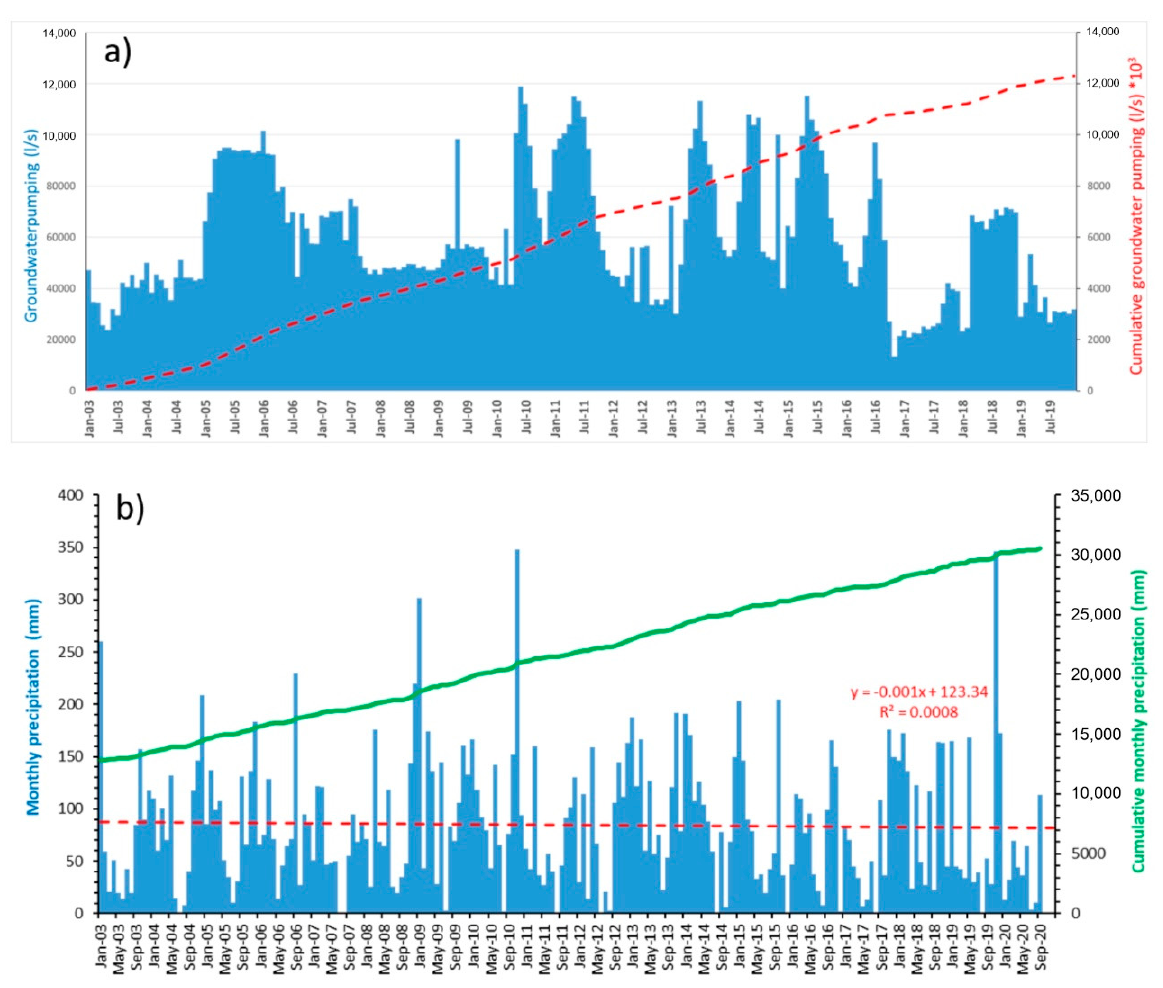
Figure 14. ( a ) total monthly groundwater pumping rate (L/s) at SF, MP, SM well fields, located within the Sarno Mountains karst aquifer, and ( b ) monthly precipitation (mm) for the period of 2003–2020. The dotted red line indicates the mean long-time trend.